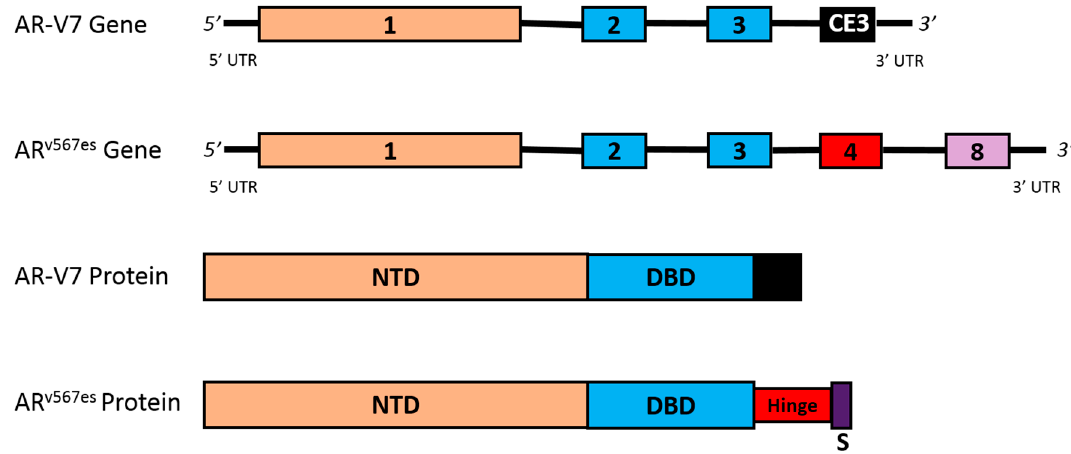
Figure 4. Clinically-relevant splice variants. This figure depicts the gene and protein structures for the AR-V7 and AR v567es splice variants. Alternate splicing of the AR leads to the formation of the constitutively active, and clinically-relevant, AR-V7 and AR v567es splice variants. AR-V7 is a variant with a cryptic exon 3 instead of exons 4–8. This alternative splicing leads to a protein that has lost the hinge region and LBD. AR v567es is a variant that contains full sequences of exons 1–4, and exon 8; however, exons 5–7 are skipped. As a result of alternative splicing, a frameshift causes the creation of a premature stop codon in exon 8. Both splice variants are constitutively active proteins that can bind to DNA to promote transcription without the need for ligand binding. Abbreviations: AR v567es , androgen receptor splice variant with exons 5–7 skipped; AR-V7, androgen receptor splice variant V7; CE3, cryptic exon 3; NTD, N-terminal transactivation domain; S, premature stop codon; UTR, untranslated region.